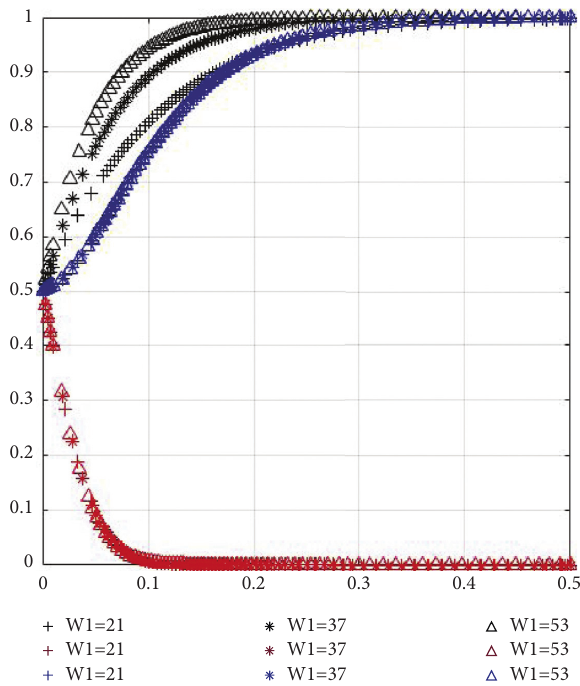
Figure 9: The government chooses not to supervise the changes in the loss of the strategy ( W 1 � 21 ⟶ W 1 � 37 ⟶ W 1 � 53).